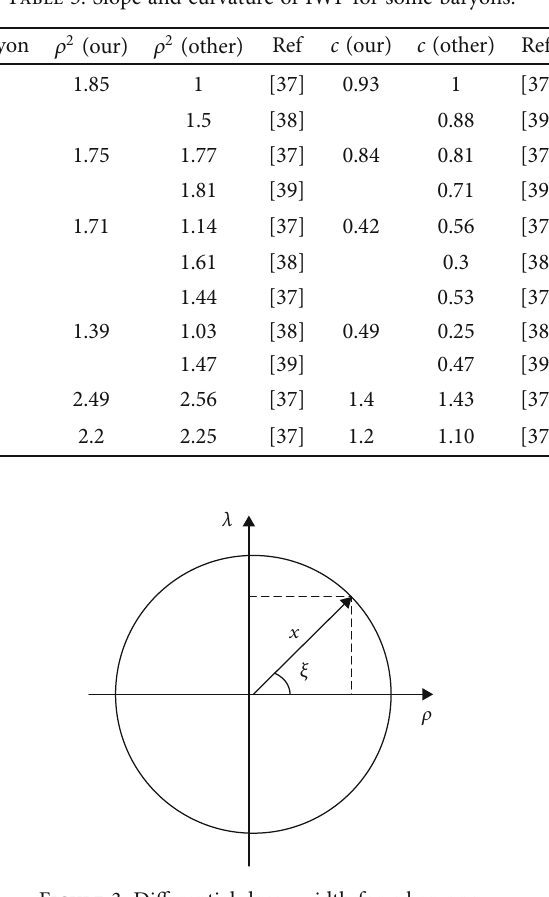
Figure 3: Di ff erential decay width for c baryons.